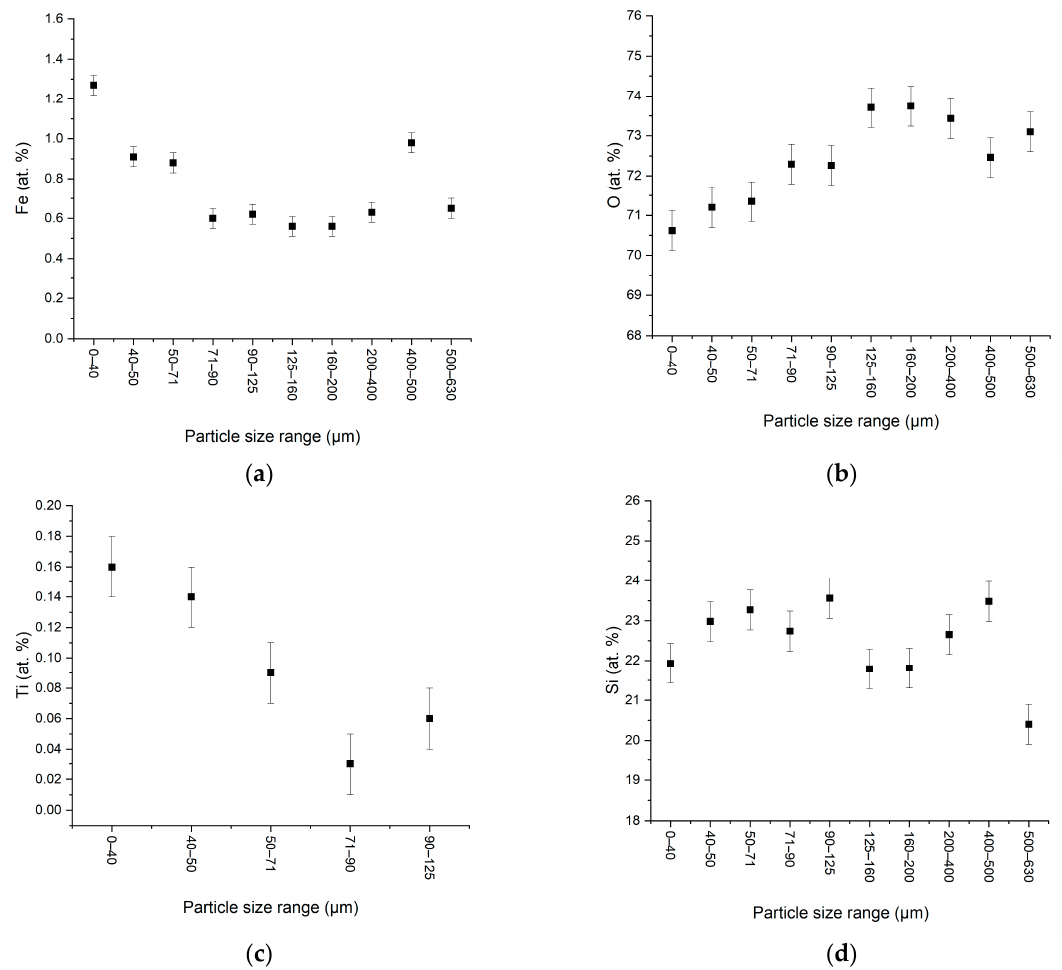
Figure 2. Elemental content of different particle size determined from the EDX analysis for Fe ( a ), O ( b ), Ti ( c ), and Si ( d ).